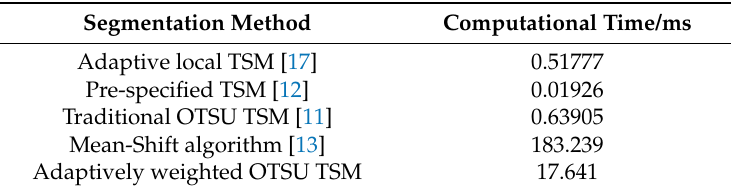
Table 2. Computational costs of different segmentation method.